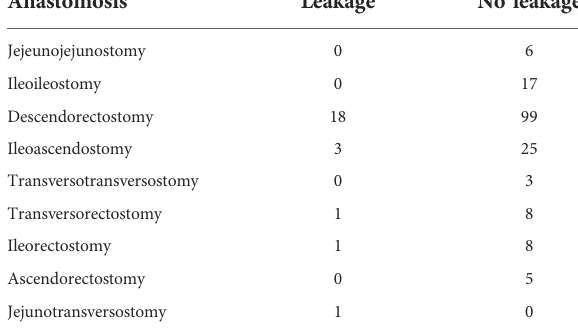
TABLE 2 199 Anastomoses.